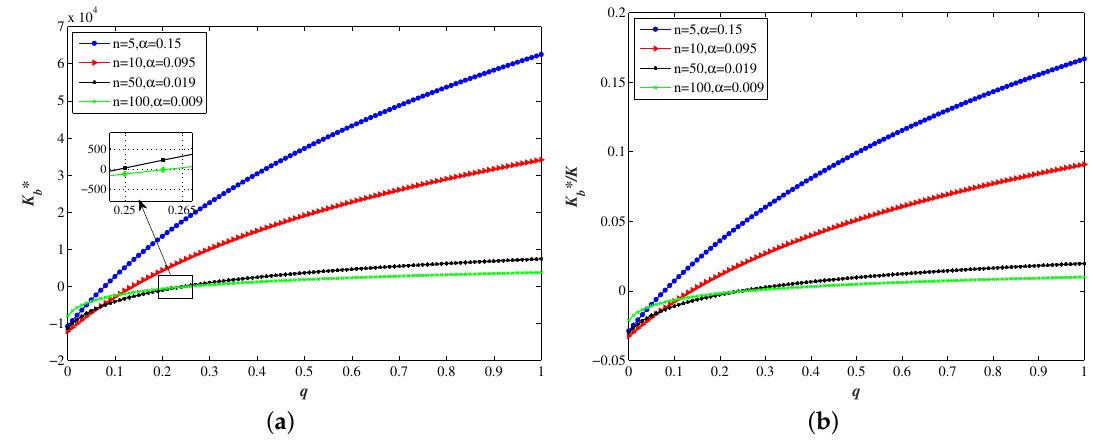
Figure 3. Optimal security investment and its allocation over propagation